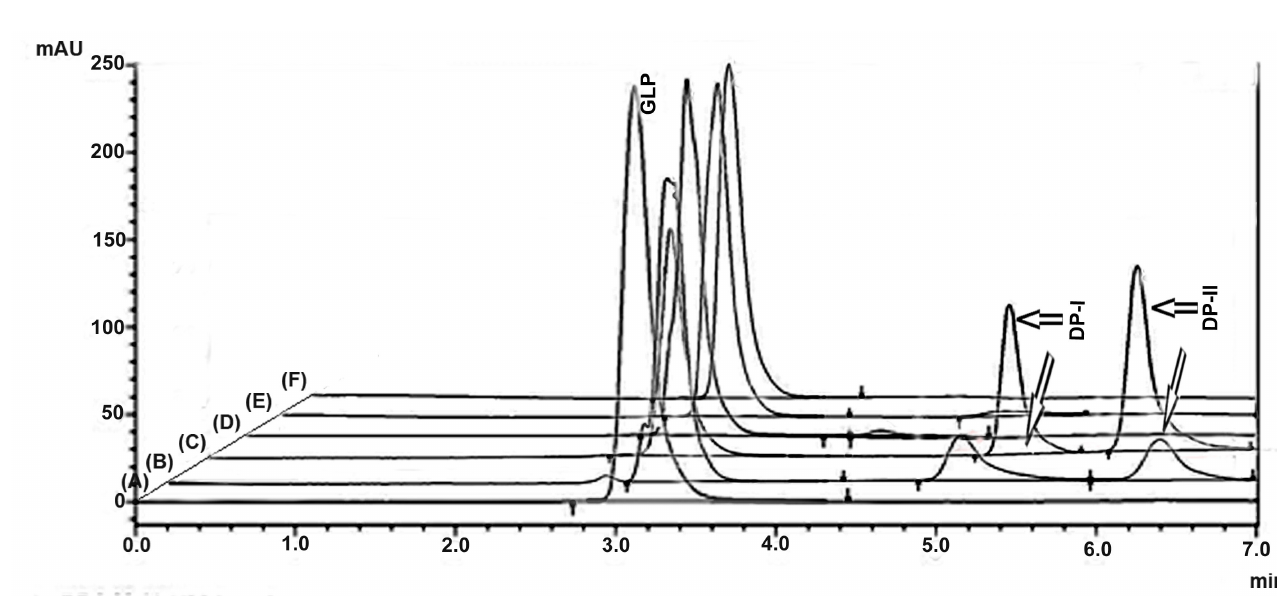
FIGURE 4 - Typical chromatograms depicting GLP pure drug (A) and after treatment with 0.1 M HCl (B), 0.01 M NaOH (C),